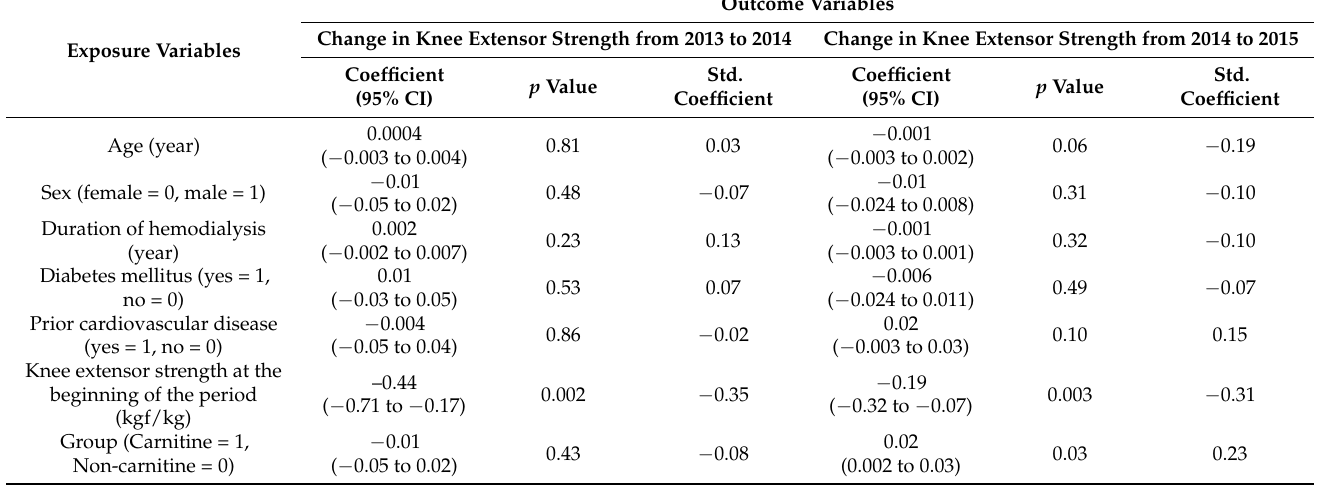
Table 2. Multivariable-adjusted linear regression analysis of factors associated with the change in knee extensor